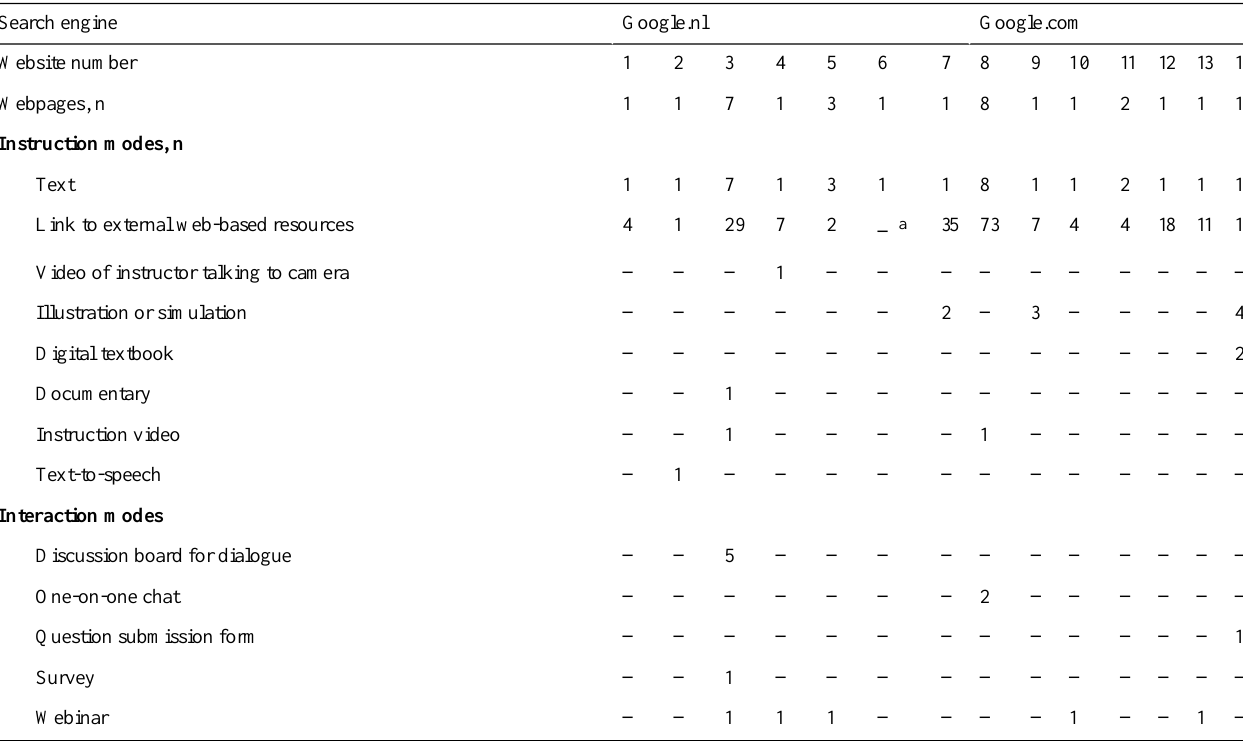
Table 2. Presence of delivery modes per included website per search engine, classified as instruction or interaction